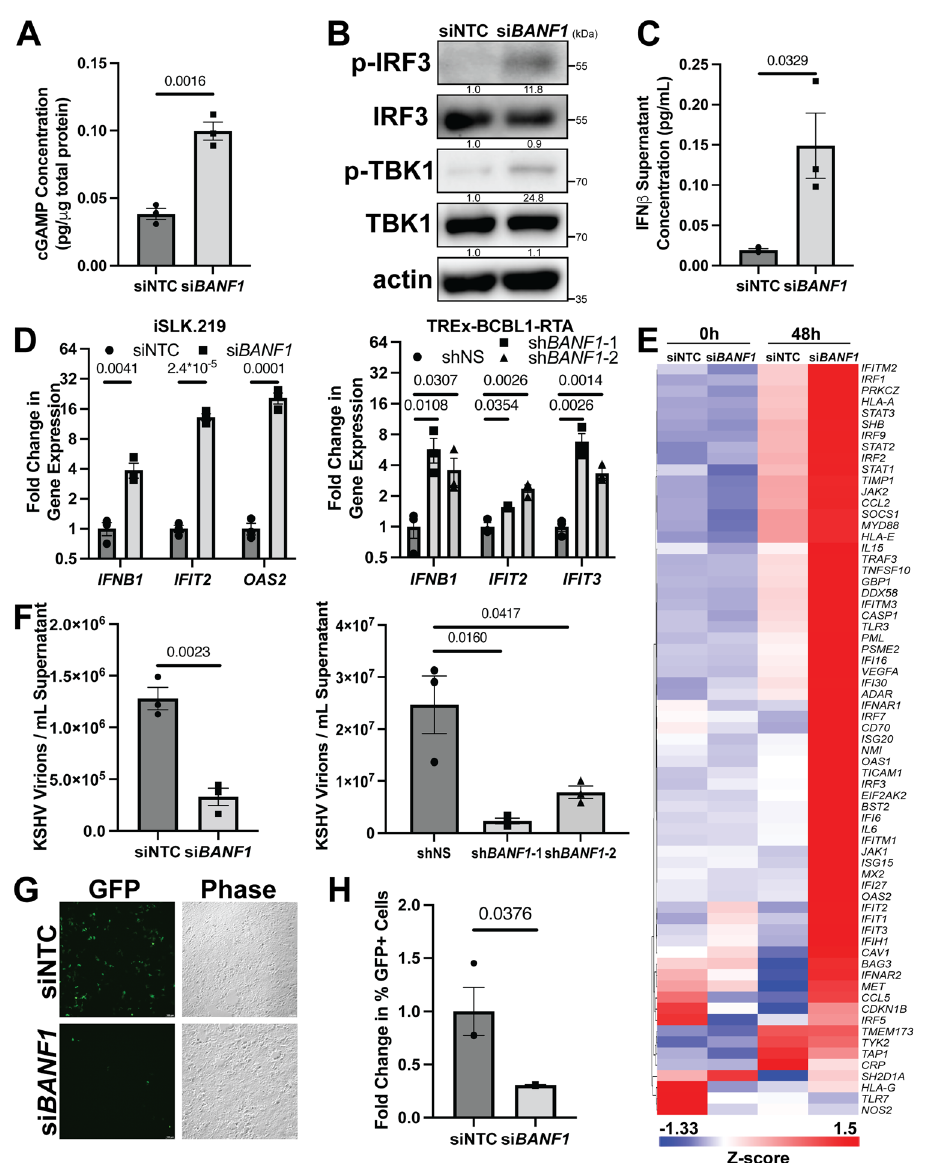
Fig. 2 | BAF antagonizes the cGAS-STING response to KSHV reactivation. iSLK.219 cells were transfected with NTC siRNA or BANF1 targeting siRNA for